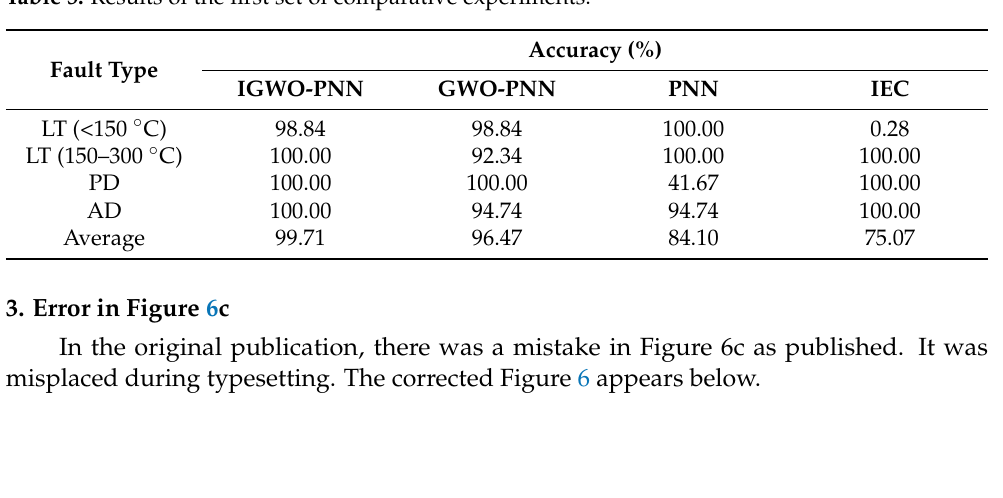
Table 5. Results of the first set of comparative